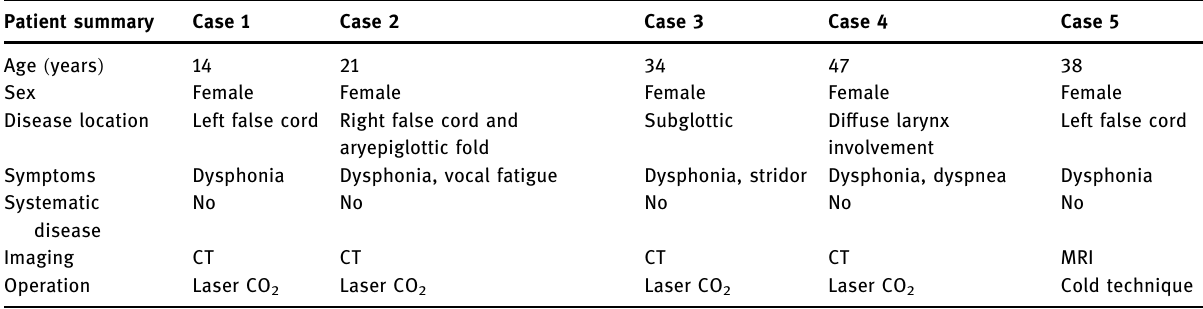
Table 1: Patient summary: demographics, disease locations, symptom, imaging and treatment Patient